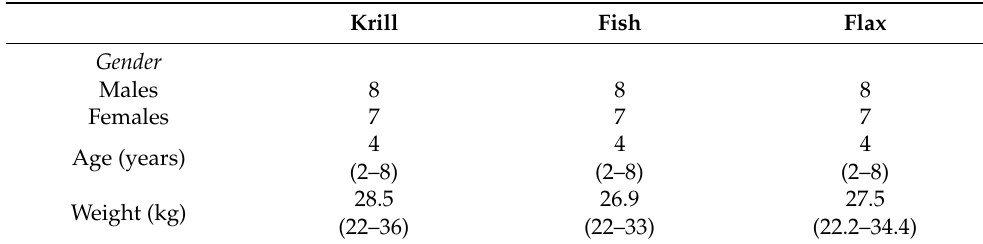
Table 1. Group characteristics of the three treatment groups.